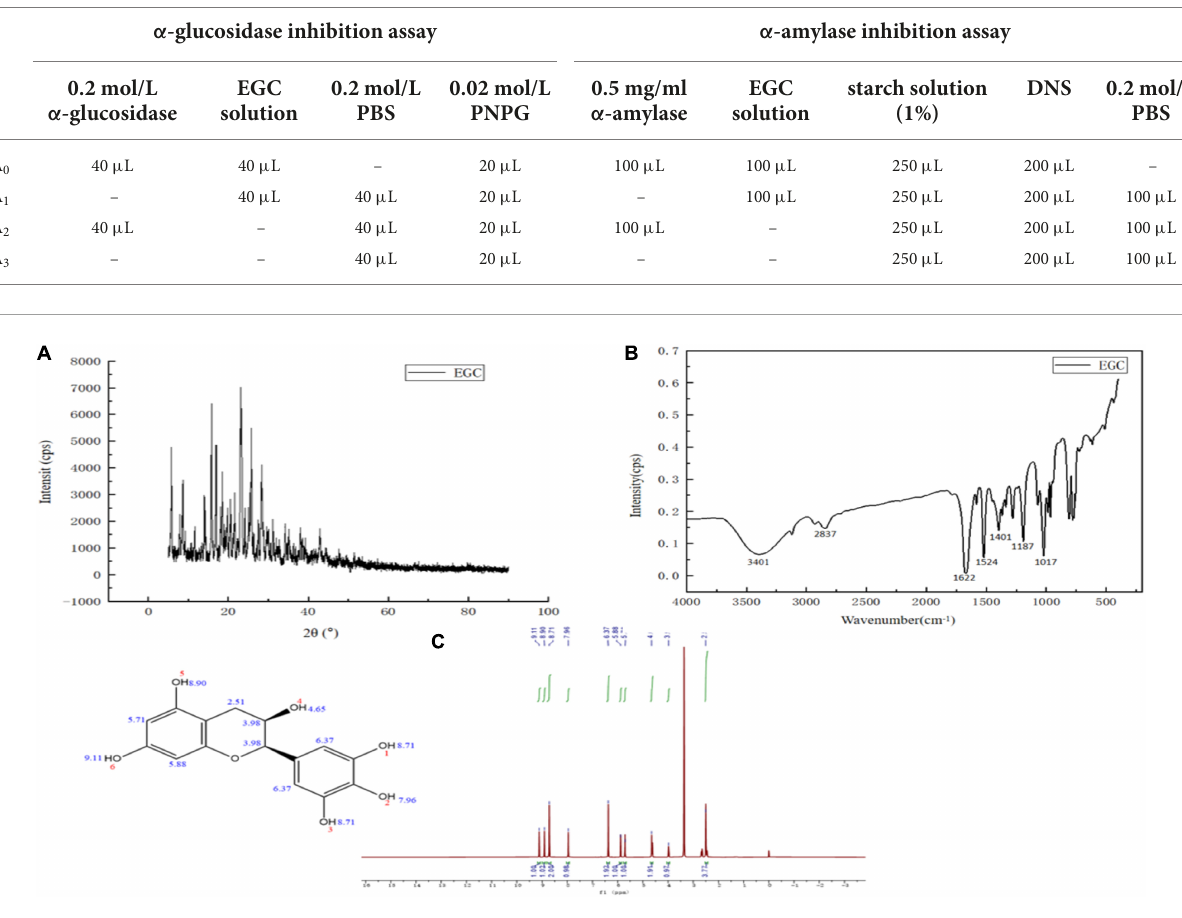
FIGURE1 Chemical structural characterization of epigallocatechin: X-ray diffraction (XRD) (A) , Fourier transform infrared (FTIR) (B) , and Proton nuclear magnetic resonance ( 1 H NMR) (C)